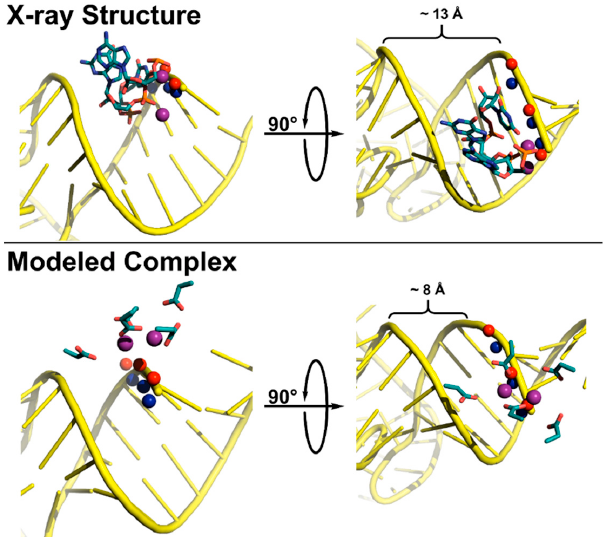
Figure 7. Active site coordination of substrate by T . maritima RNase P (top, x ‐ ray crystal structure) and A . thaliana PRORP1 (bottom, complex modeled in PyMOL). The minor groove width was measured as the distance between the non ‐ bridging phosphate oxygens. Top : T . maritima product complex crystal structure (PDB 3q1r) [22]. Pro ‐ R P (blue spheres) and pro ‐ S P (red spheres) oxygen atoms of tRNA product (yellow cartoon) shown for N(+1)–N(+3). Active site metal atoms